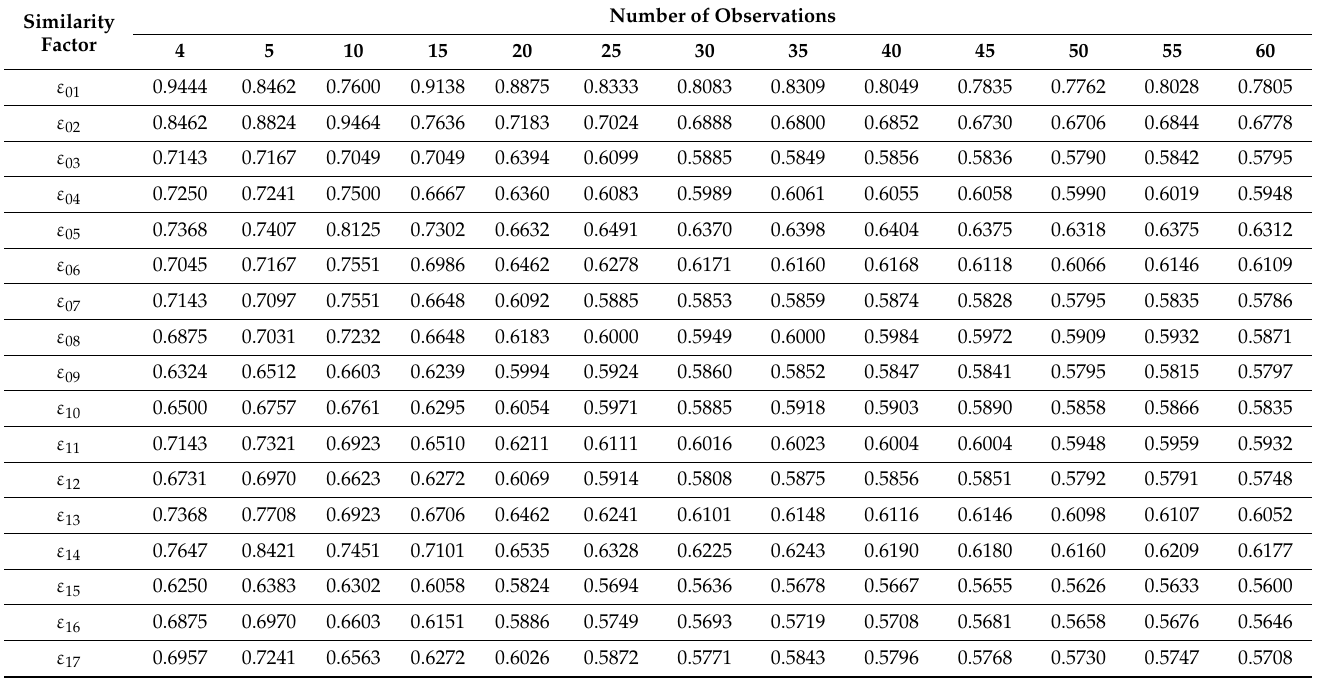
Table 2. Values of the similarity coefficient ε in terms of the number of observations.